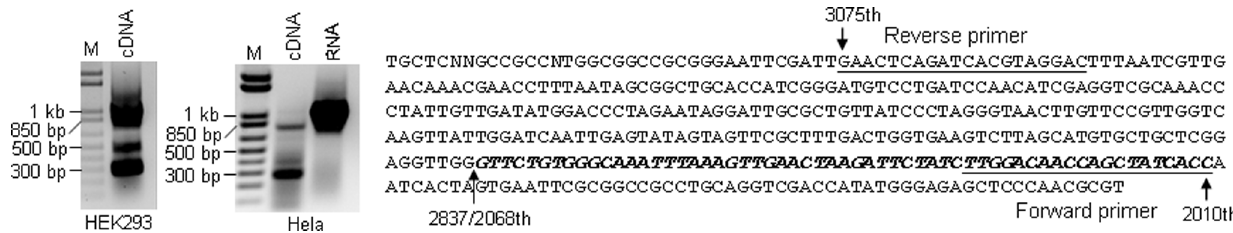
Figure 6. Expression of 16SrRNA-s. RT-PCR with primers that amplify the 2010-3075th region of mtDNA detects a 300-bp band and a 500-bp band, besides the anticipated band at about 1-kb, in HEK293 cells. The 500-bp band occurs randomly with greatly variable density, thus likely being a heterodimer of the 300-bp and 1-kb cDNAs, which appears randomly and is a common phenomenon as we have frequently described [37,39,40]. Isolation of the 300-bp band followed by T-A cloning and sequencing reveals that it is an mtRNA with a 768-bp (the 2069–2836th nt region of mtDNA) deletion, as indicated in the sequence. The boldfaced sequence is the downstream exon. The number of the nt is based on the UCSC browser, with the position of the last nt in the reverse primer (underlined) and the first nt in the forward primer (underlined) indicated. The sequences outside the primers belong to the T-A vector. Because the RNA sample was not pre-digested with DNase, the 1-kb band should be derived from not only cDNA, but also mtDNA, of the 16S rRNA gene. Removal of DNA from an RNA sample from Hela cells followed by RT- PCR (cDNA) still detects the 300-bp band, besides a band at about 850-bp, while the 1-kb band was very weak. Cloning and sequencing the 850-bp band reveal that it is part of the 16S rRNA that was amplified because the reverse primer is also partly reverse-complementary to the mtDNA. Direct PCR amplification of the RNA sample without RT (RNA) detects only the 1-kb band, but not the 300-bp one, indicating that the 300-bp band is not associated with an mtDNA with